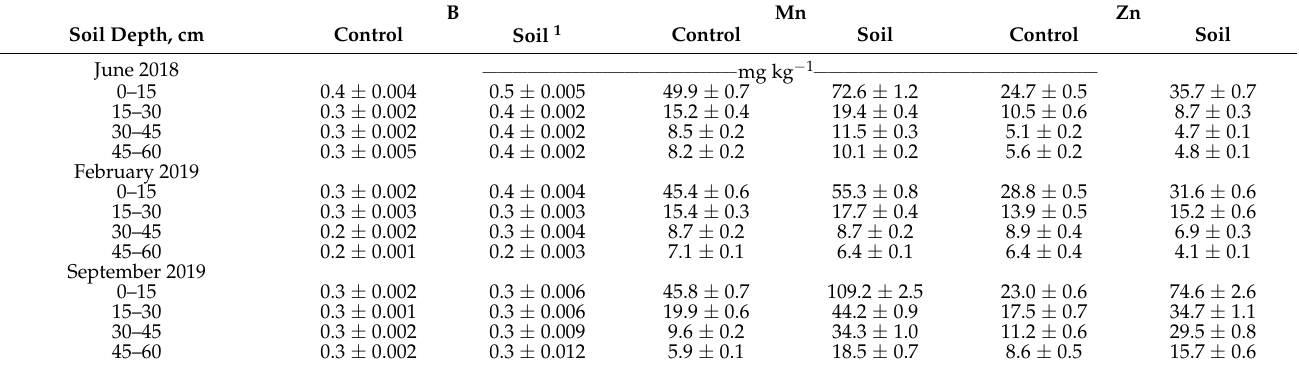
Table 4. Soil B, Mn, and Zn distribution as a function of soil depth and sampling time with 95% confidence intervals (as measured in Control (standard rate) plots and soil applied (Treatment 4